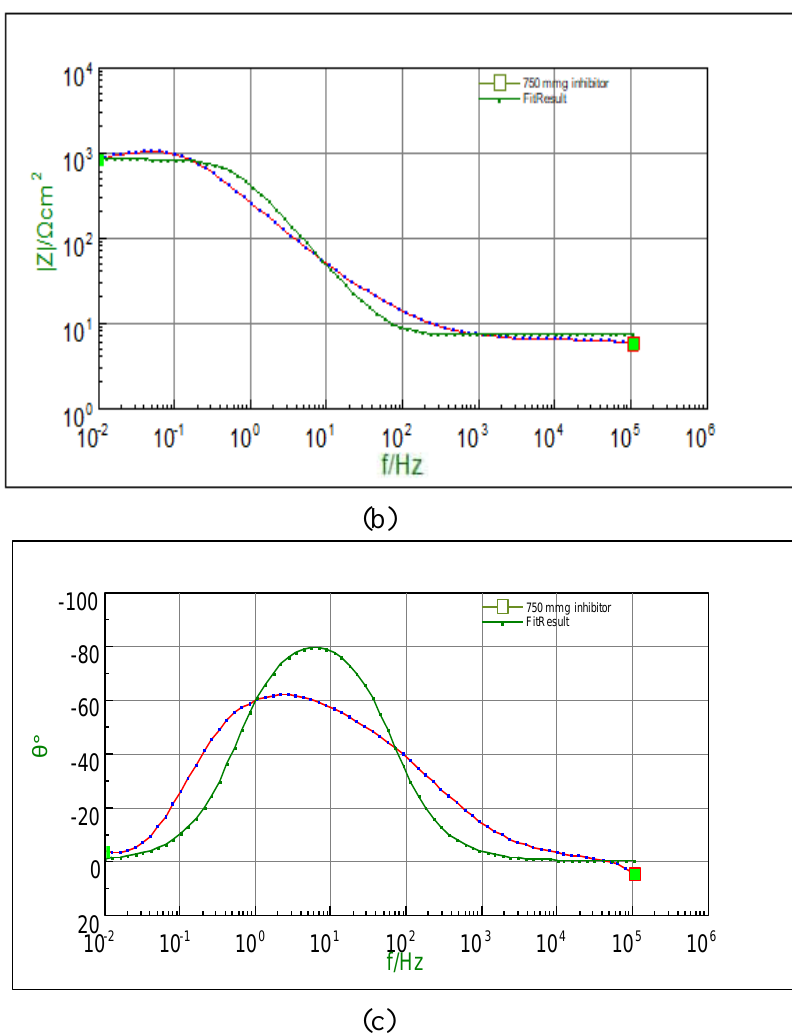
Fig. 11. The EIS test for 750 mg/l concentration of inhibitor at 25◦C with the fitting result. (a) Nyquist plot, (b, c) Bod (log versus |z|), and phase angle (log f versus ∝ 𝟎 )